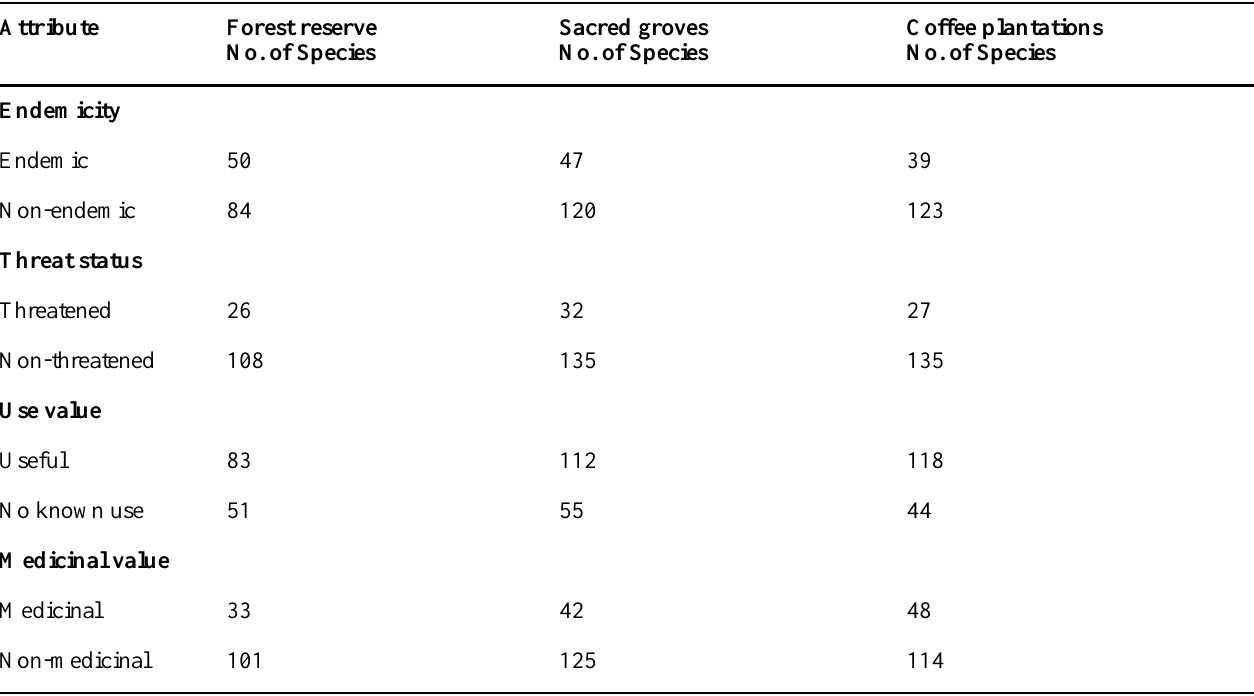
Table 2. The distribution of endemic, threatened, useful, and medicinal trees in Kodagu, Western Ghats of India